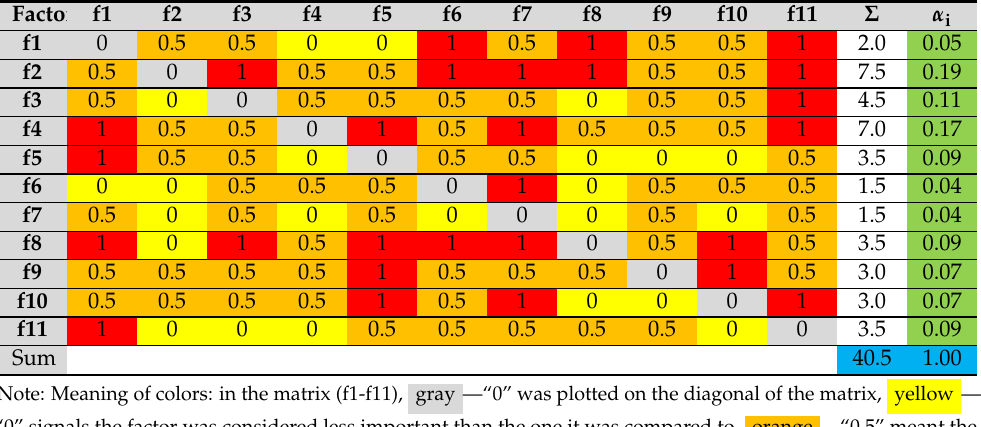
Table 2. Quantification of decision-making factors weight.